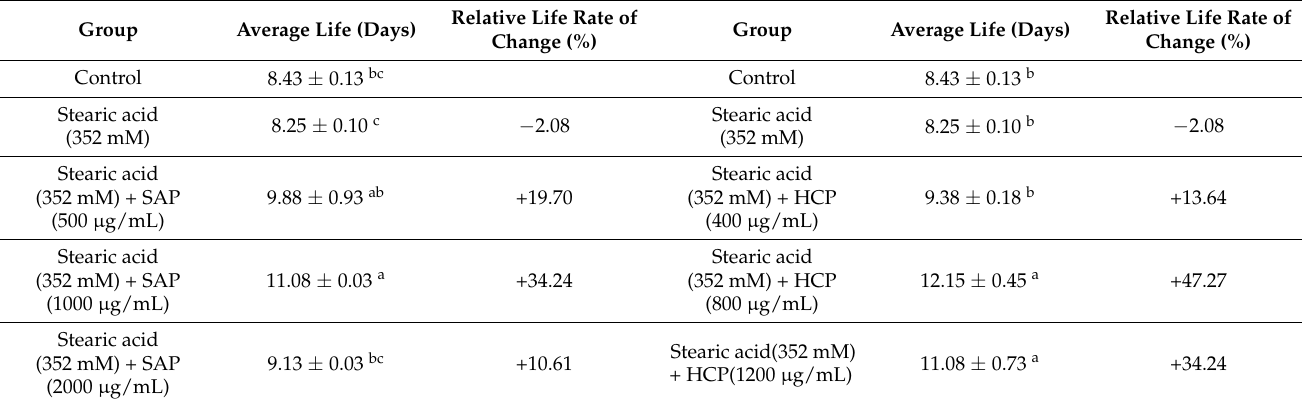
Table 4. The mean lifespan of stearic acid-incubated C. elegans treated with SAP and